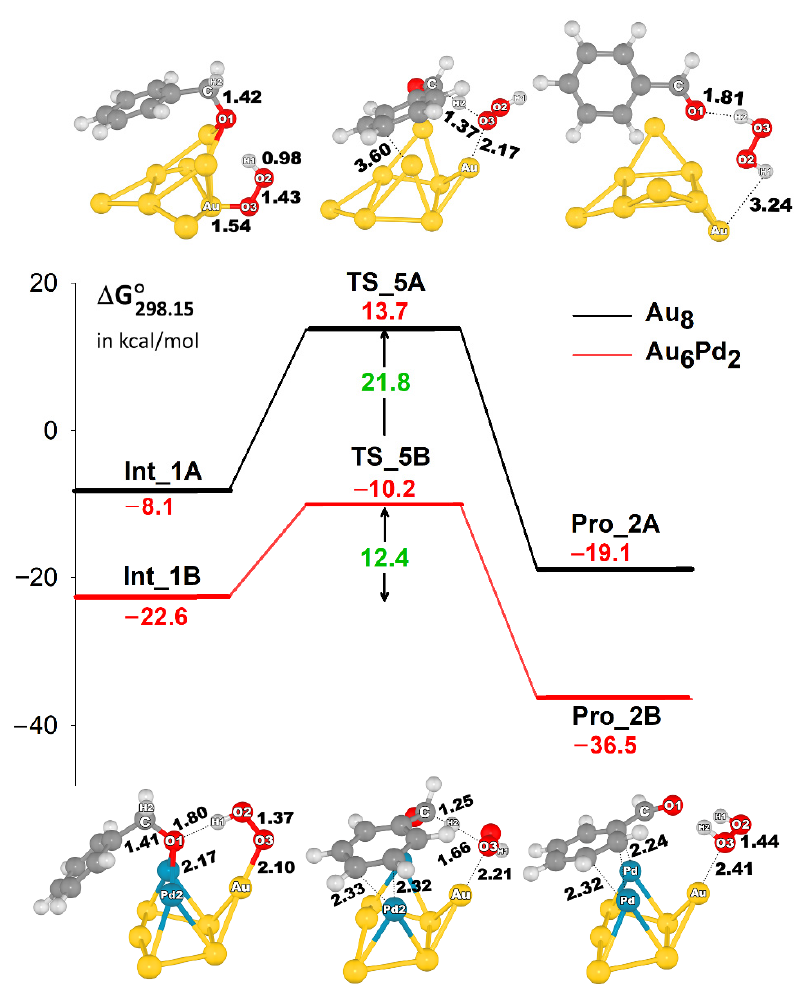
Figure 7. Calculated energy profile and optimized structures for the aerobic oxidation of second benzyl alcohol over Au 8 -O and Au 6 Pd 2 -O species generating benzaldehyde and H 2 O 2 . All energy values are shown in kcal/mol and the distances are given in Å.